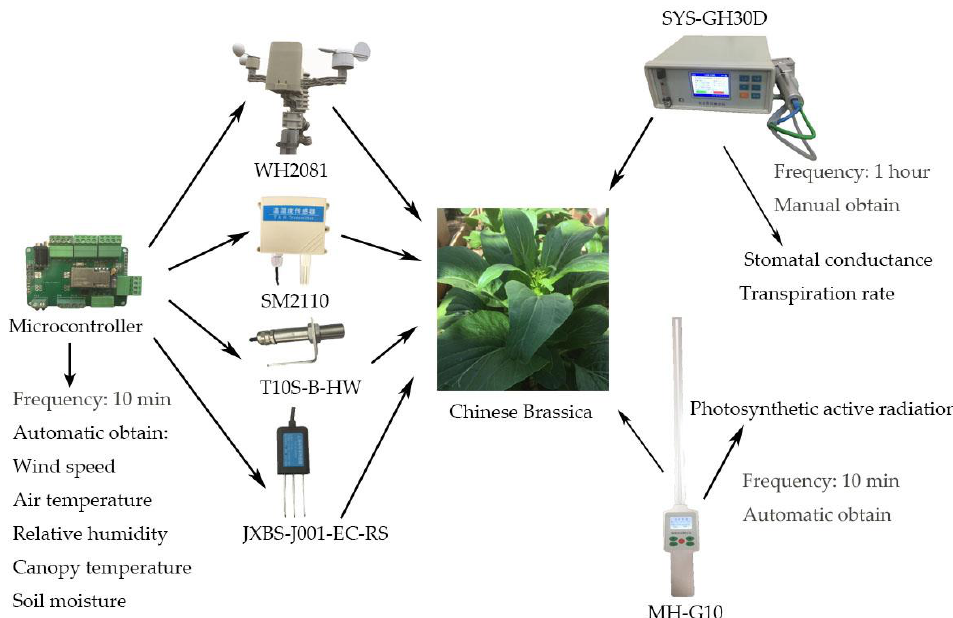
Figure 2. The acquisition mode of data including the air temperature, relative humidity, wind speed, photosynthetic active radiation, canopy temperature, stomatal conductance, transpiration rate, and soil moisture. Table 2. Maximum (max), minimum (min), mean, and standard derivation (Std) of the climatic val- ues for E1 and E2.